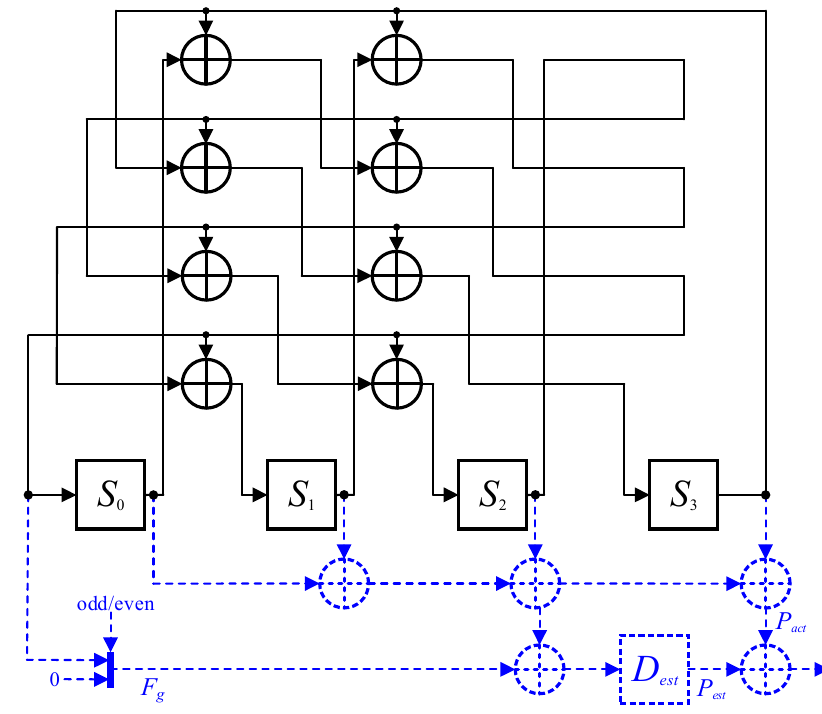
Figure 6. Structure of the proposed LFSR with a parallel factor of 4.